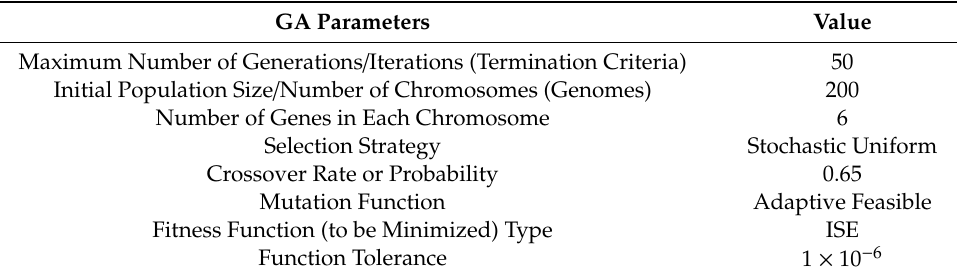
Figure 5. Control signal to the plant. Table 3. The genetic algorithm (GA) parameter values.